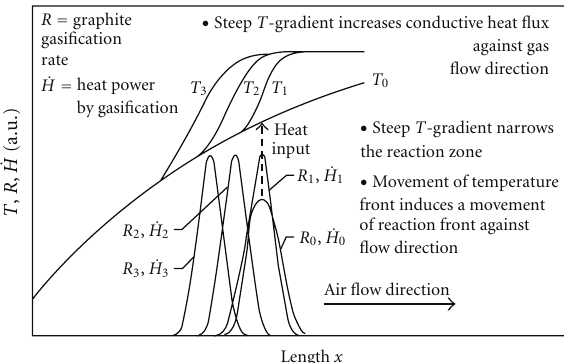
Figure 2: Schematics of a moving reaction front in course of graphite